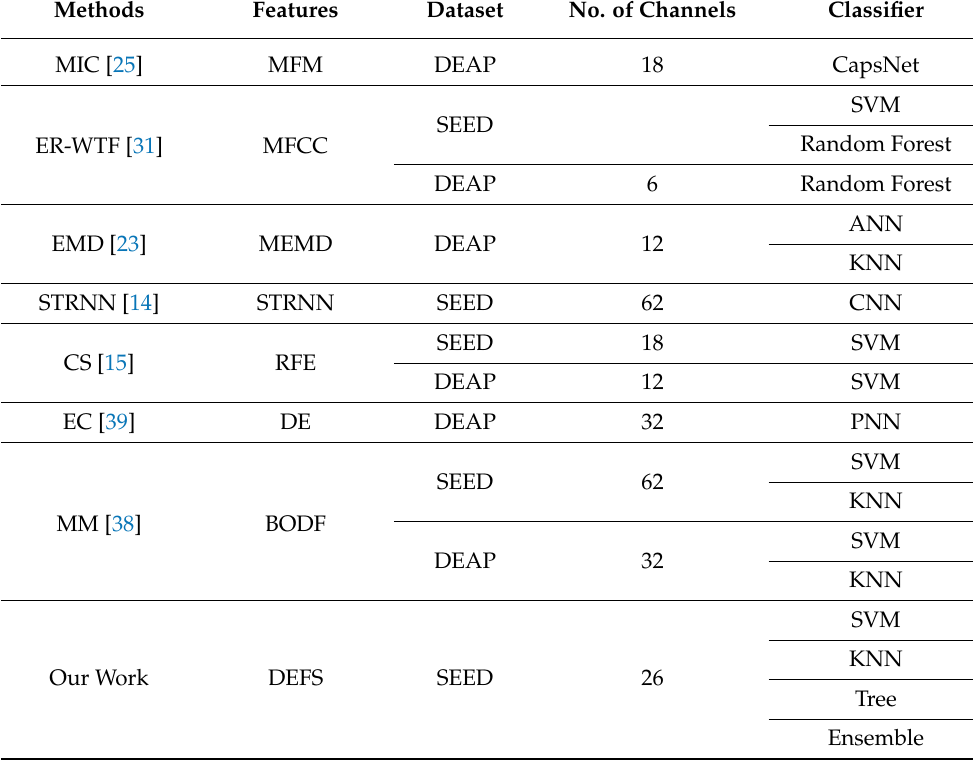
Table 1. Comparison of our proposed work with the previous studies.